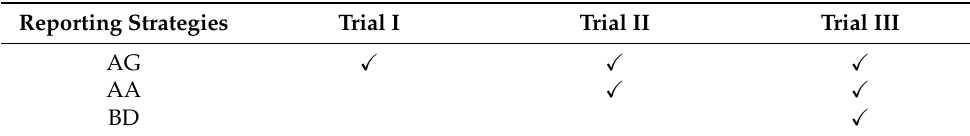
Table 7. Inclusion of RSs in the real-life trials. Reporting Strategies